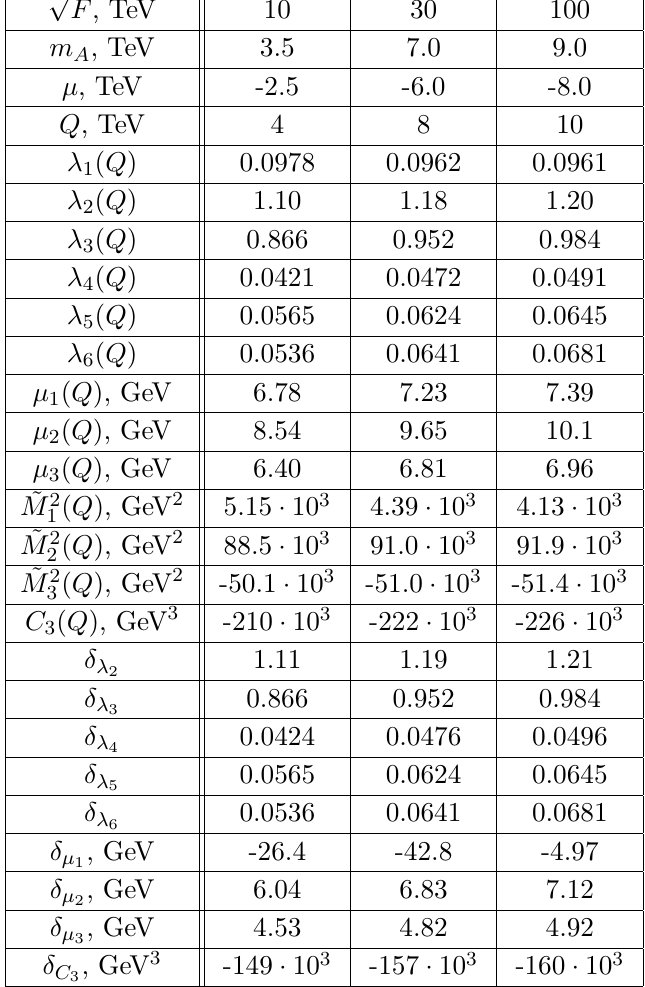
Table 3 . Reconstruction of physical parameters at high energies for the benchmark model Q 2 with tan β = 10